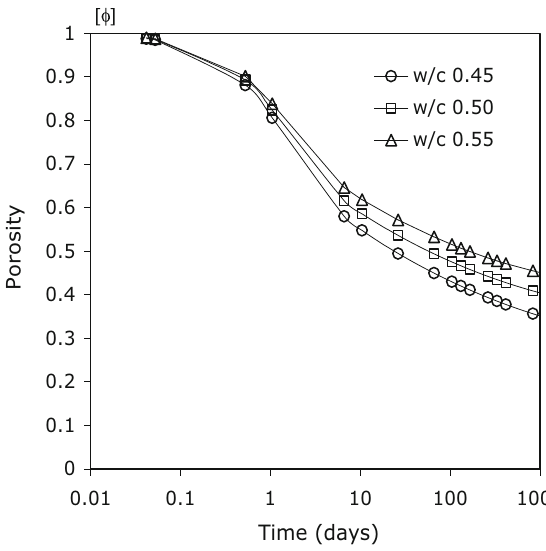
Fig. 2 Time evolution of capillary porosity in OPC cement paste for various w/c ratios.